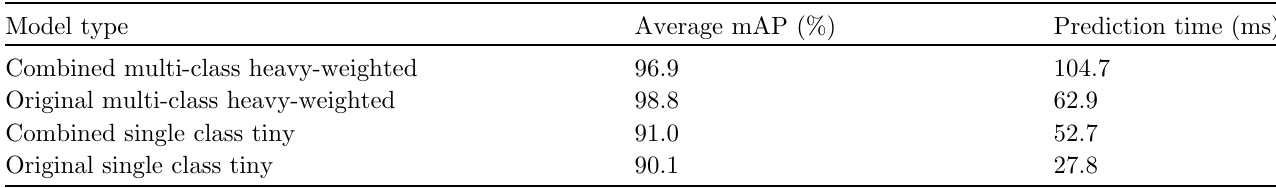
Table 3. The performance of multi-class heavy-weighted and tiny YOLOv4, comparing original and models formed by a combination of two single class